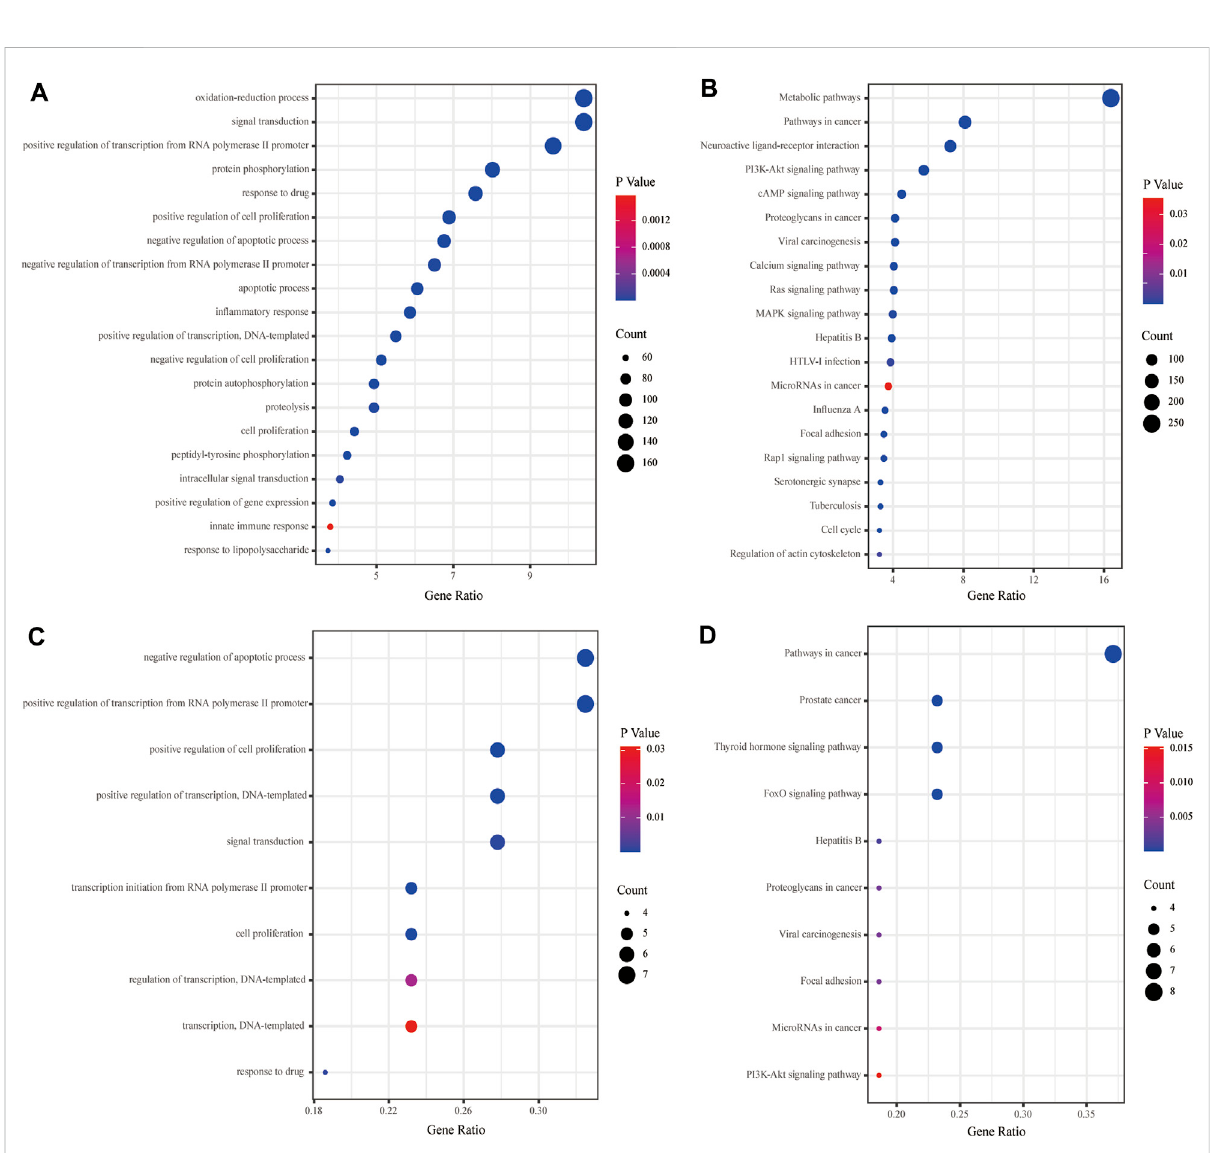
FIGURE 5 The functional enrichment analyses of the KXYA putative-target genes and the key genes. (A) Enriched biological processes of the KXYA putative-target genes. (B) Enriched KEGG pathways of the KXYA putative-target genes. (C) Enriched biological processes of the key genes. (D) Enriched KEGG pathways of the key